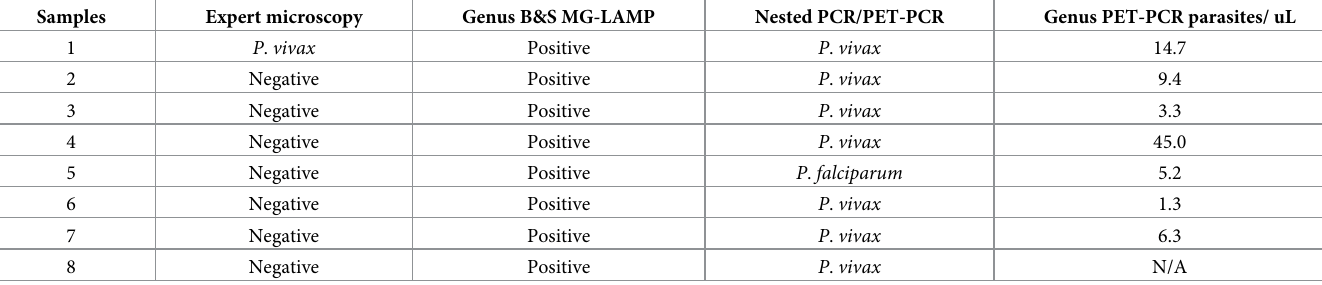
Table 2. Results of positive from the active surveillance study. The remaining 493 samples were negative.